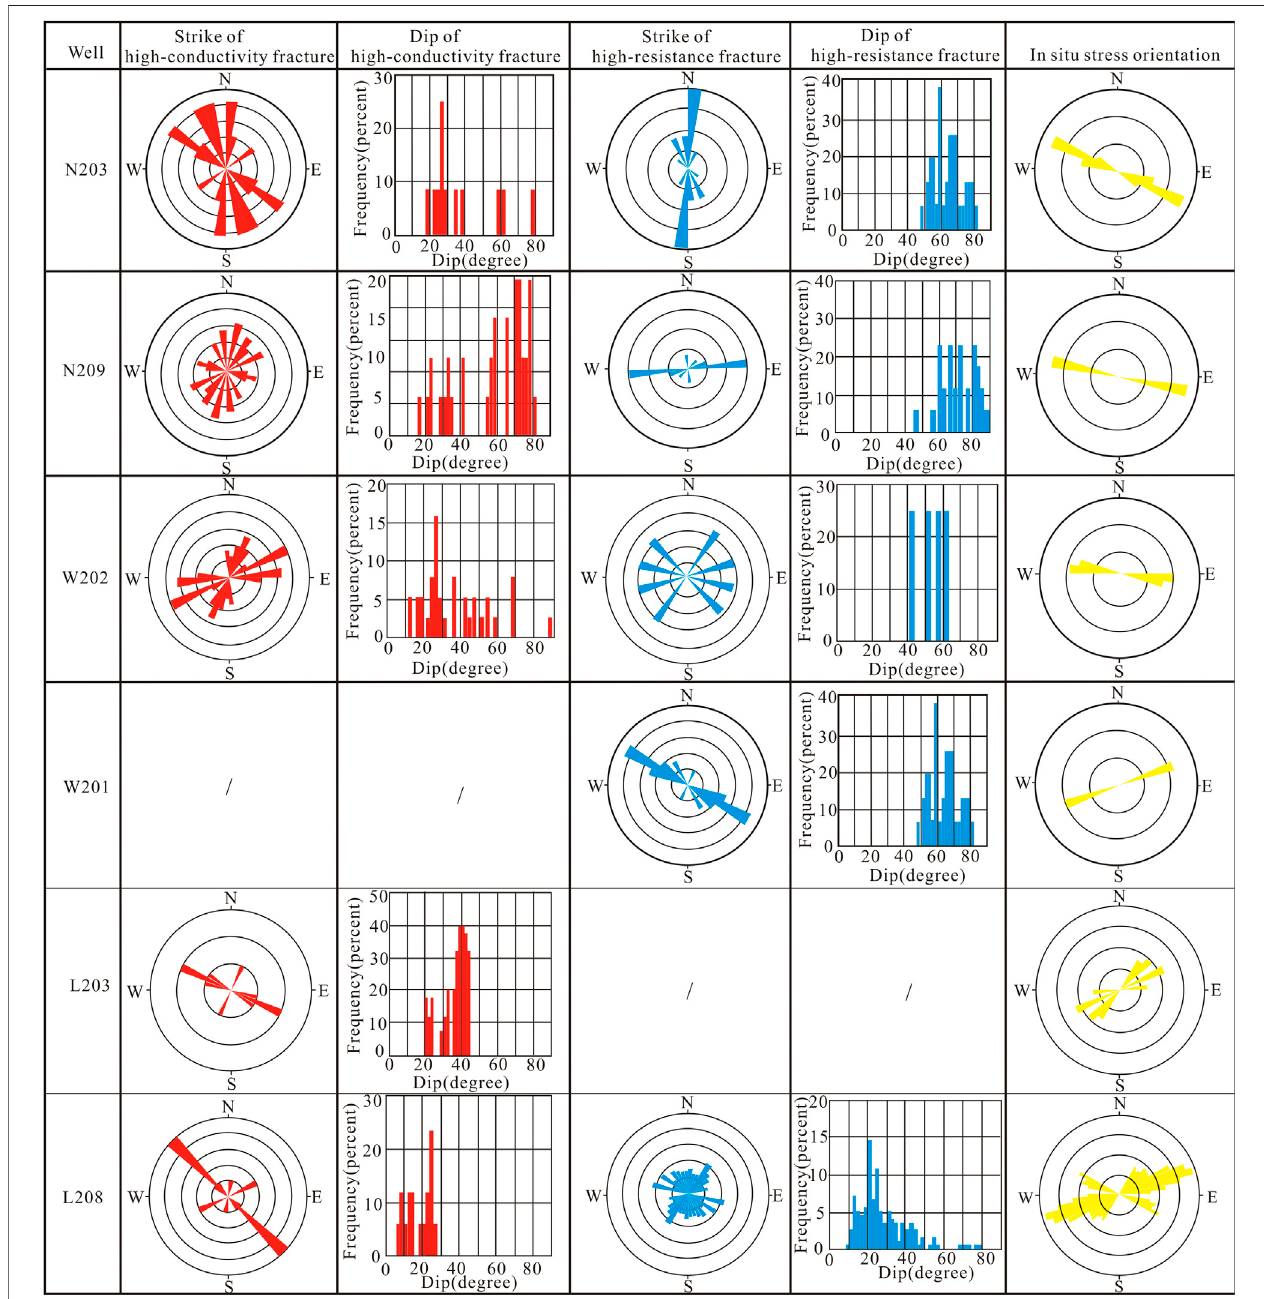
FIGURE 11 | Relationship among the orientation of the high-resistance shale gas fractures, the high-resistance fractures and the ground stress.